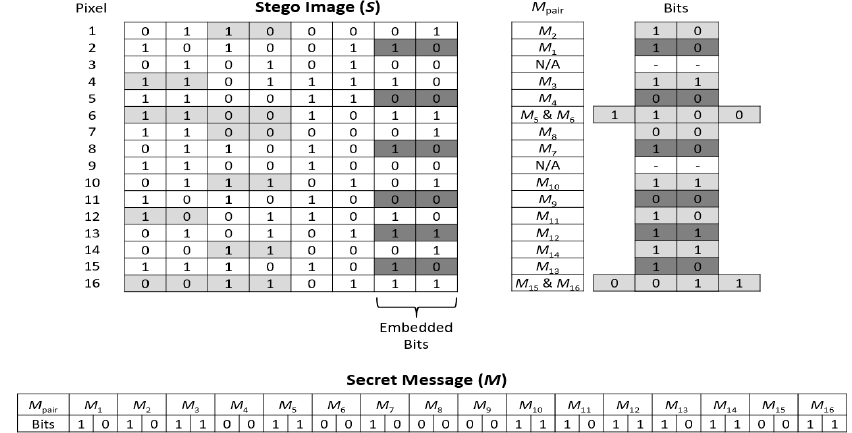
Figure 2. Stego image and a secret message. Table 3. The proposed extraction steps.